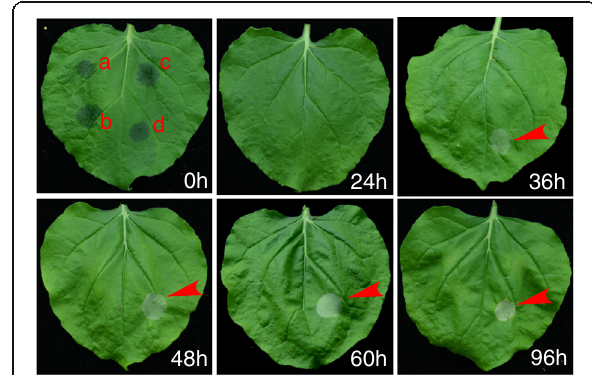
Fig. 4 Expression of nrtp1-D in tobacco leaves induces necrotic lesions. Necrotic lesions were observed after transient expression of nrtp1-D in tobacco leaves. Each leaf was injected at four sites, with a, water; b, empty vector control; c, NRTP1 ; and d, nrtp1-D . Arrow heads indicate necrotic lesions caused by cell